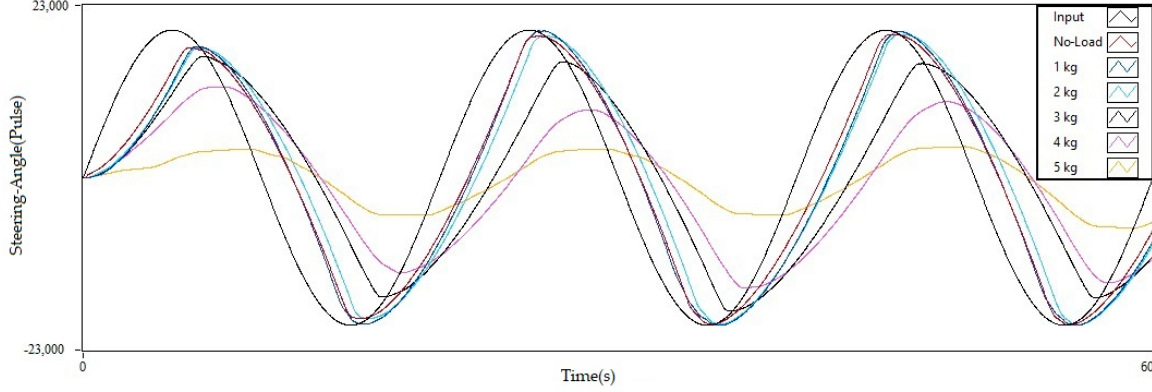
Figure 15. Pulse output on the steering with loading variation of the motor shaft.